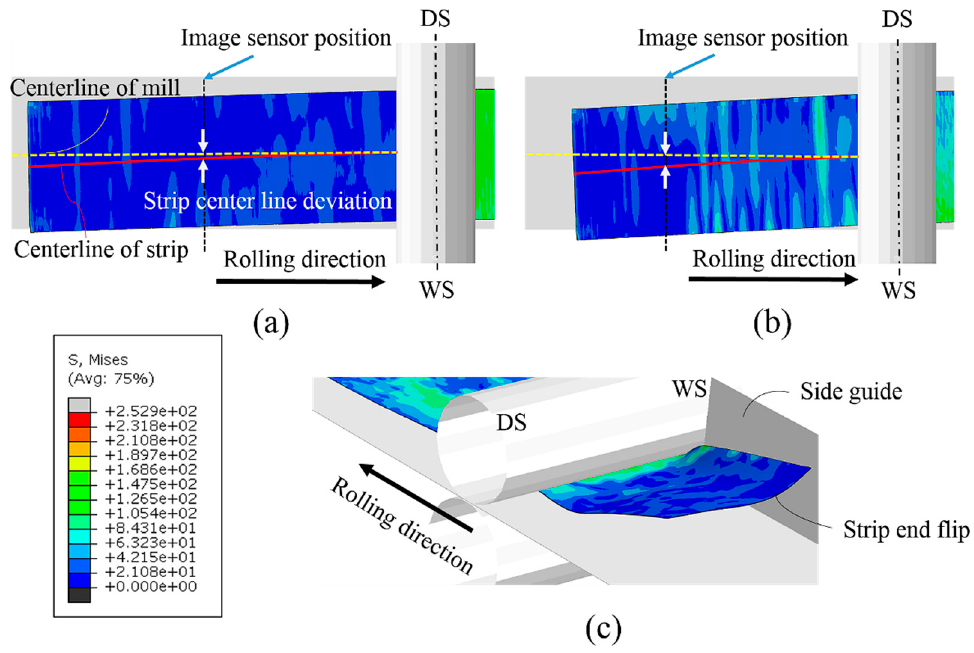
Figure 8. Instantaneous strip shape showing centerline deviation at ( a ) t = 0.48 s (top view), ( b ) t = 0.72 s (top view). ( c ) Strip end flip occurred at t = 0.84 s (rear view). The centerline deviation of the particular strip obtained from on-site data and of the simulated ones was compared in Figure 9. The blue solid line denotes the centerline deviation of the particular strip. The data was recorded by an image sensor installed behind the mill stand. The curve of the centerline deviation first bent in the direction of the WS, and when the strip sidewalk was limited by the side guide with an opening of about 40 mm on each side, an inversion of the centerline curve was observed, indicating the correction of the strip centerline by the side guide. The simulation result of strip end motion without the constraint of the side guide shows a curved centerline deviation in the direction of WS, which is shown as a red dotted curve. If the side guide was added to the numerical model, the deviation curve (black dotted line) exhibited a deflection at t = 0.62 s and then an inversion in the direction of DS, indicating the contact of the strip with the side guide followed by the subsequent inversion of the centerline and the beginning of the strip end flip. The consistency of the simulated results and the on-site data in trend demonstrated the ability of the numerical model to further predict the deviation of the centerline and dynamic behavior of the strip end under various clearance configurations. The on-site recorded curve revealed somewhat of an inconsistency with the simulated one after t = 0.62 s. This is mainly because that the strip end began fluctuating and flipping after collision with the side guide. The centerline position of the strip end was first recorded by video camera and then decoded into position data. The irregular curve shape after t = 0.62 s in Figure 9, to some extent, reflects the irregular flipping of the strip end, which cannot be exactly simulated by the numerical model.